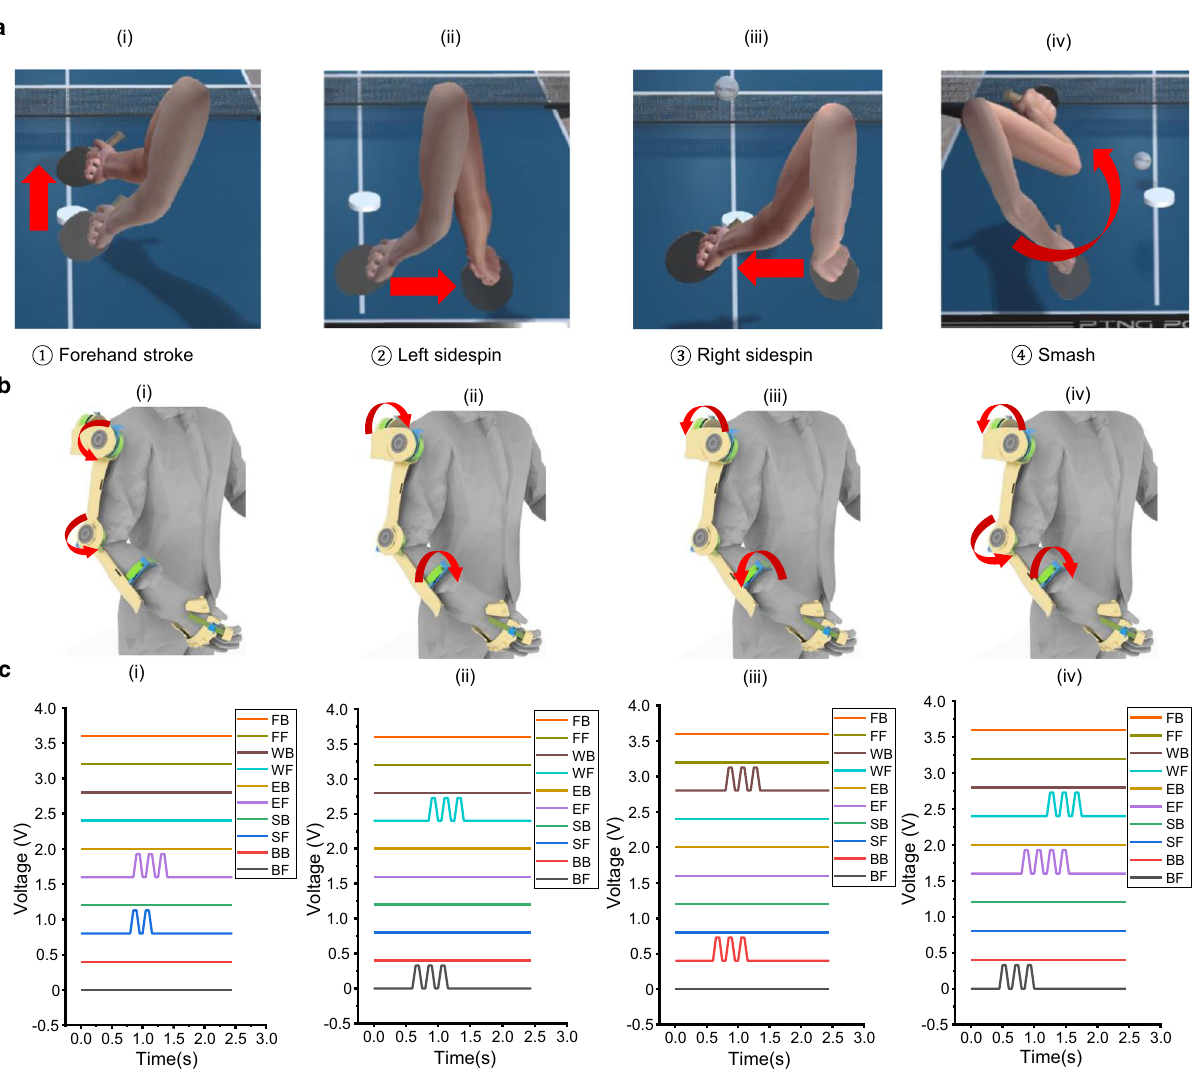
Fig. 5 Demonstration of ping-pong training program for simultaneous monitoring of multiple sensing signals. a Illustrations of four striking motions in ping-pong game, (i) forehand stroke, (ii) left sidespin, (iii) right sidespin, and (iv) smash. b The main activated sensors on exoskeleton for the corresponding strikes, the rotation direction of each sensor is marked by red arrow. c The real-time signals generated from four strikes, the channels of BF, BB, SF, SB, EF, EB, WF, WB, FF, and FB represent the forward (clockwise) and the backward (counterclockwise) rotations of the rotational triboelectric bidirectional back (RTBD-B) sensor, the rotational triboelectric bidirectional shoulder (RTBD-S) sensor, the rotational triboelectric bidirectional elbow (RTBD-E) sensor, the rotational triboelectric bidirectional wrist (RTBD-W) sensor, and the linear triboelectric bidirectional fi nger (LTBD-F)